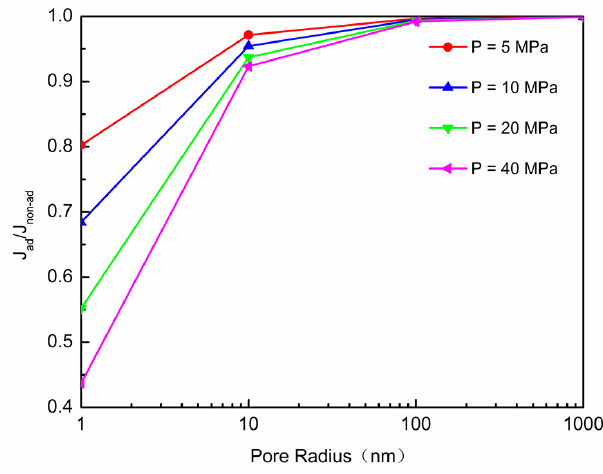
Figure 7. J ad /J non-ad ratio versus pore radius for various pressures.